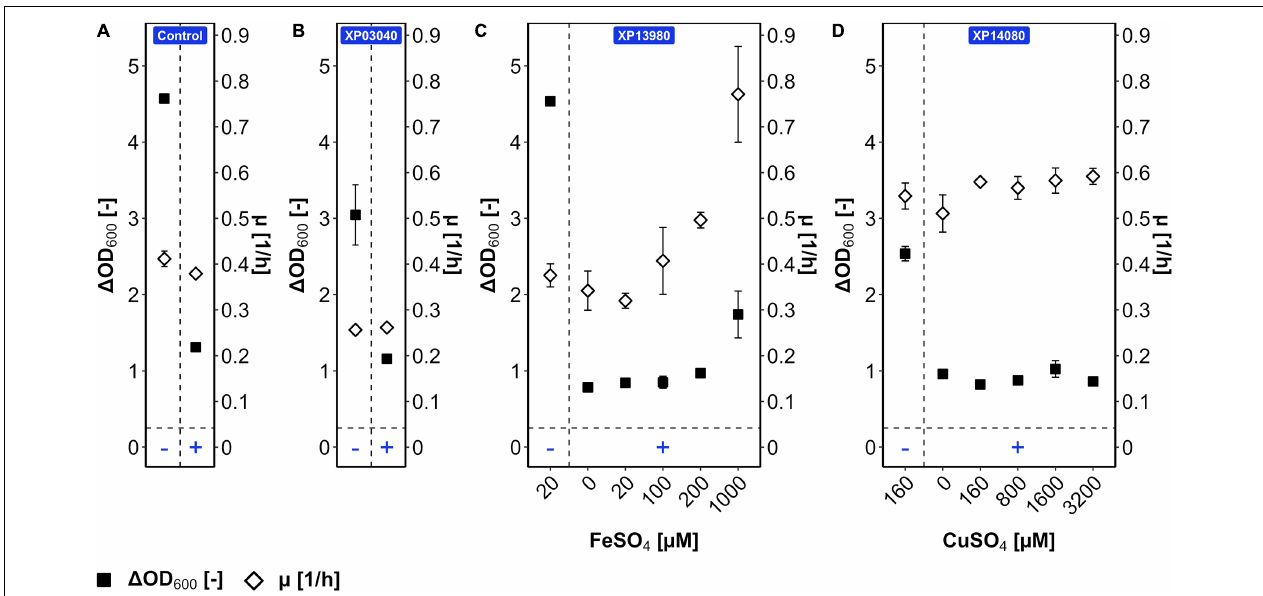
FIGURE 6 | Tolerance of B. methanolicus WT (pBV2xp) (A) , XP03040 (B) , XP13980 (C) , and XP14080 (D) for 5AVA with cofactor titration. B. methanolicus cells were cultivated in MVcMY in the presence ( + ) and absence ( − ) of 50 mM 5AVA. The growth rates (empty diamonds) and (cid:49) OD 600 (full squares) were determined. The cofactors FeSO 4 (0–1,000 µ M) and CuSO 4 (0–3,200 µ M) were titrated for strains XP13980 (C) and XP14080 (D) , respectively, according to the function of proteins coded by their overexpressed genes and ligand prediction with COACH-D. Values and error bars represent means and standard deviations of triplicate